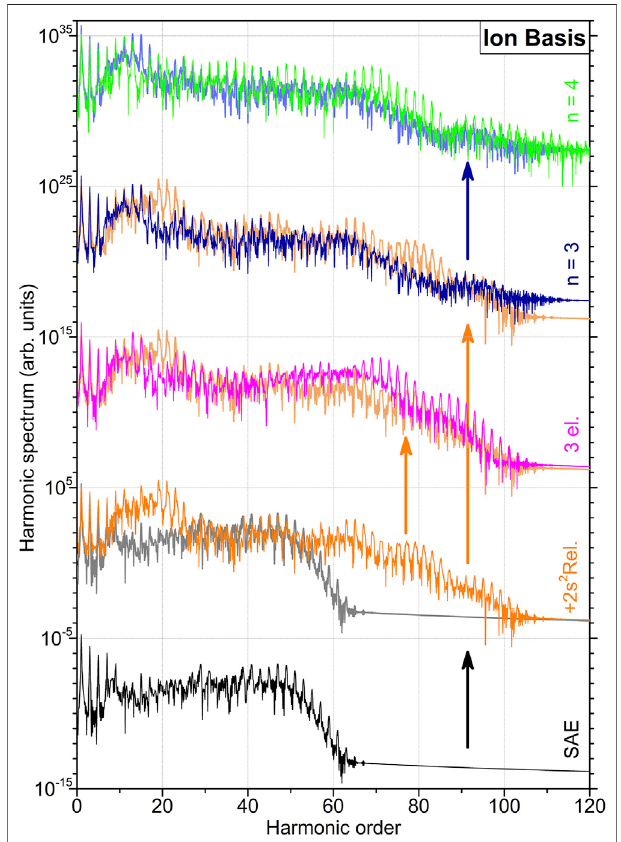
FIGURE 2 | High-order harmonic generation spectra of beryllium atom computedinthebasisset{ ϕ α }ofionicstatesathigherlevelsofapproximations (indicated at the right-hand vertical axis, see also caption of Figure 1 for details on the data representation). The two lowermost spectra, obtainedintheSAEapproximationandinthe2DCapproximation byincluding physical effects upto2 s 2 + relaxation, are the same as therespective spectra in Figure 1 . The spectrum in the middle, obtained in the 1FC approximation, illustrates an impact of the three-electron correlations, as compared to that of the 2DC approximation (also indicated by the respective colored arrow). The spectra shown in the two uppermost rows represent results obtained within the 2DC approximation by additionally (as compared to that of the 2DC approximation, see also respective colored arrows) extending the ionic basis set { ϕ α } fi rst with all n ℓ + orbitals with principal quantum n = 3 and then with n = 4.